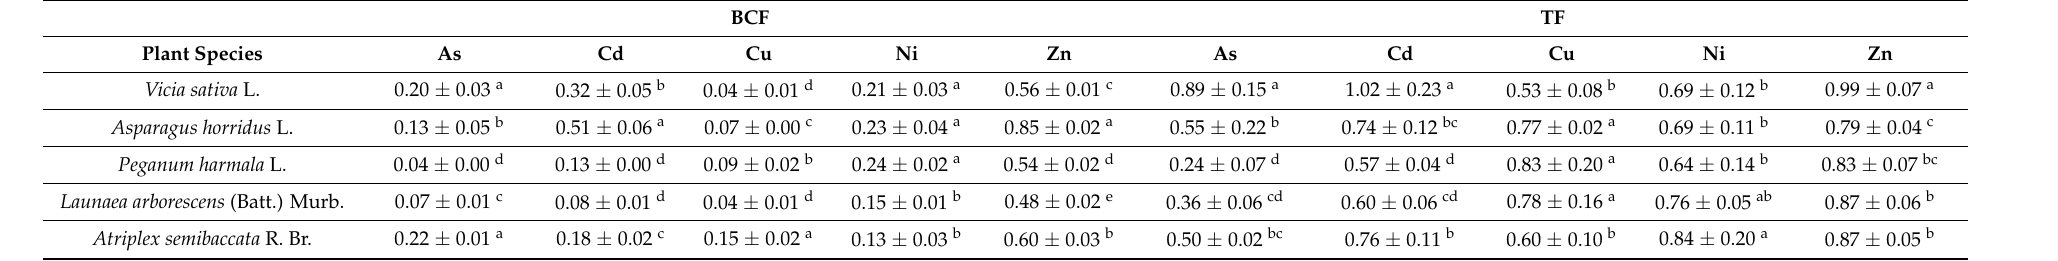
Table 2. Translocation factor (TF) and bioconcentration factor (BCF) of the different species sampled for each element.